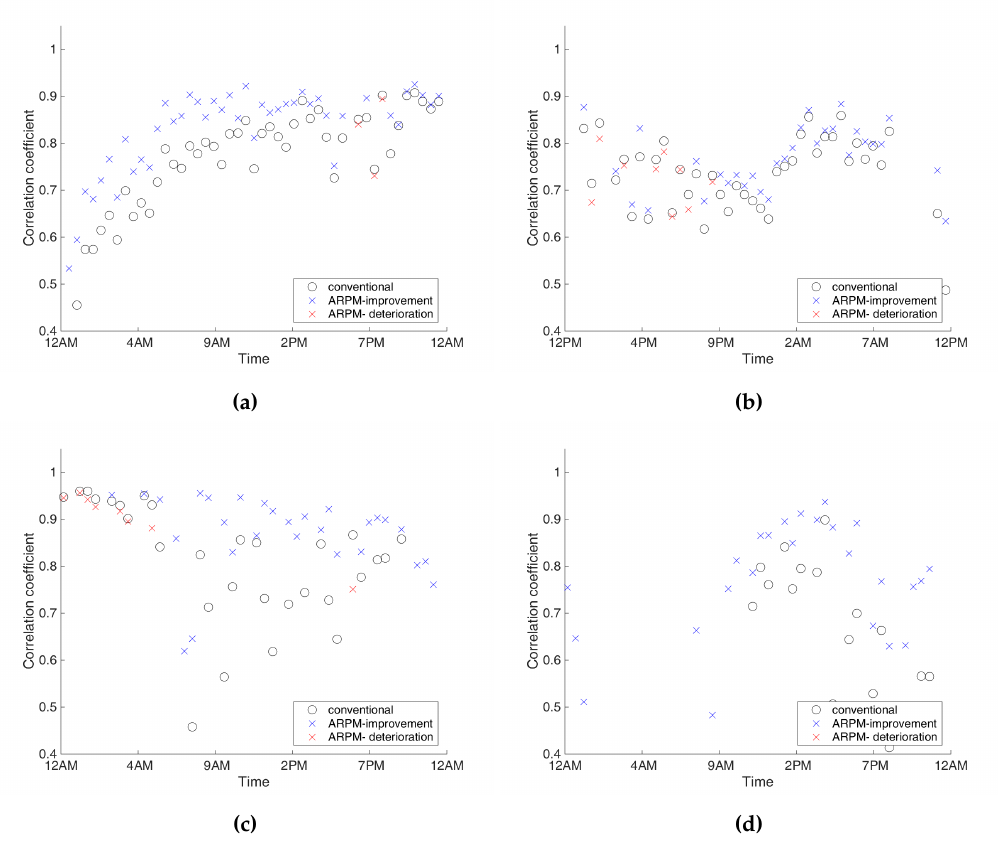
Figure 12. A comparison between the ARPM and the standard method in terms of the frequency wave spectrum similarity with respect to the buoy ground truth spectra. Each point represents the correlation coefficient between ground truth and the radar data 30 min averaged frequency wave spectra. ( a – d ) 27 November, 29 November, Dec 1 and 3 December